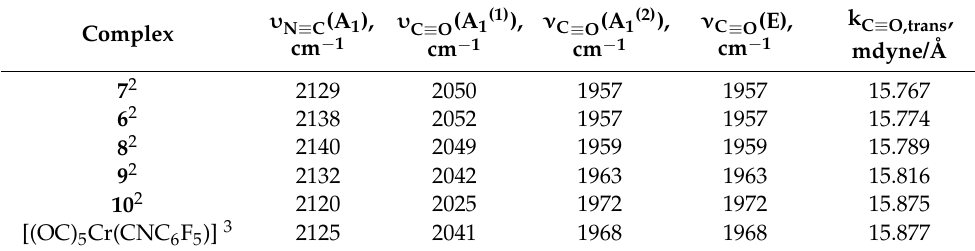
Table 4. Infrared signatures of 6 – 10 and [(OC) 5 Cr(CNC 6 F 5 )] in υ N ≡ C and υ C ≡ O regions 1 .